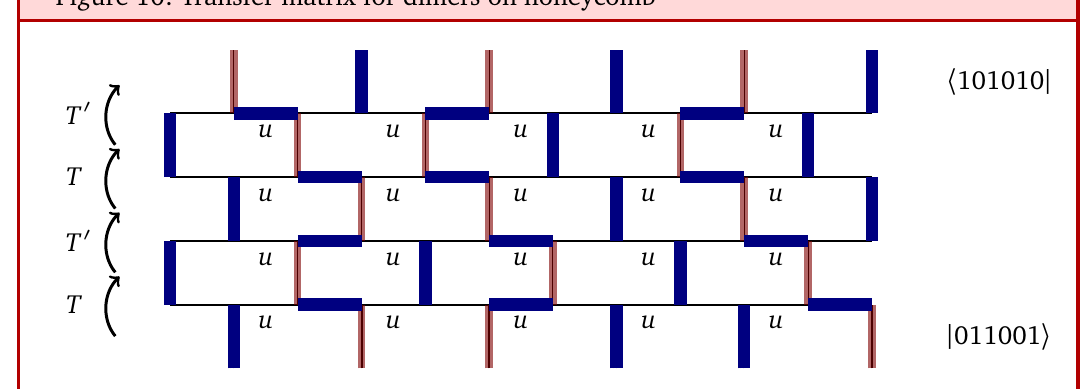
( L = 6 ) × ( M = 4 ) hexagonal lattice. An example of dimer covering (dimers are thick blue lines). We see the occupancy of the top and bottom vertical edges as imposed. In thinner dark red are drawn the vertical edges not occupied by dimers, those become particles (1) in the following, while real dimers are holes